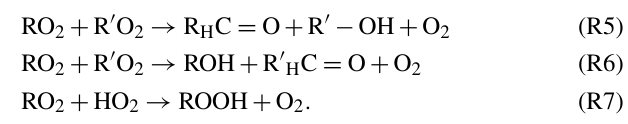
two-deuterium-containing C